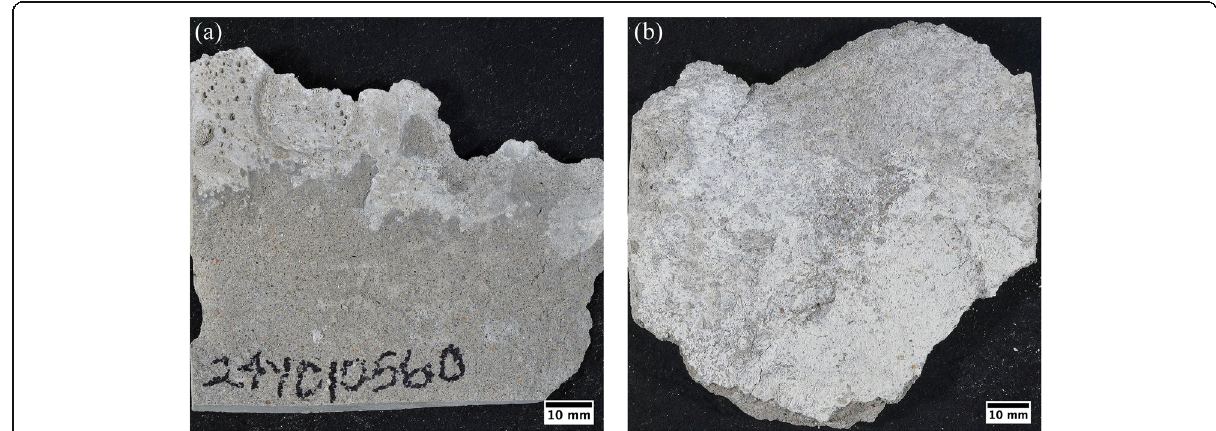
Fig. 2 The conditions of the as-received fragments of the undamaged field mortar ( a ) and the damaged field mortar ( b ),